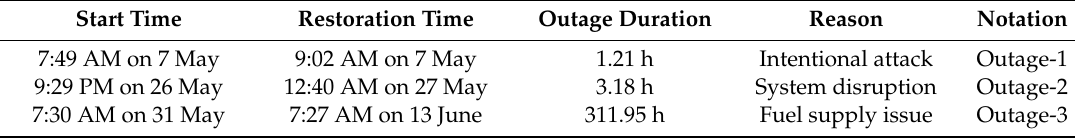
Table 1. Data on power outages in New York,